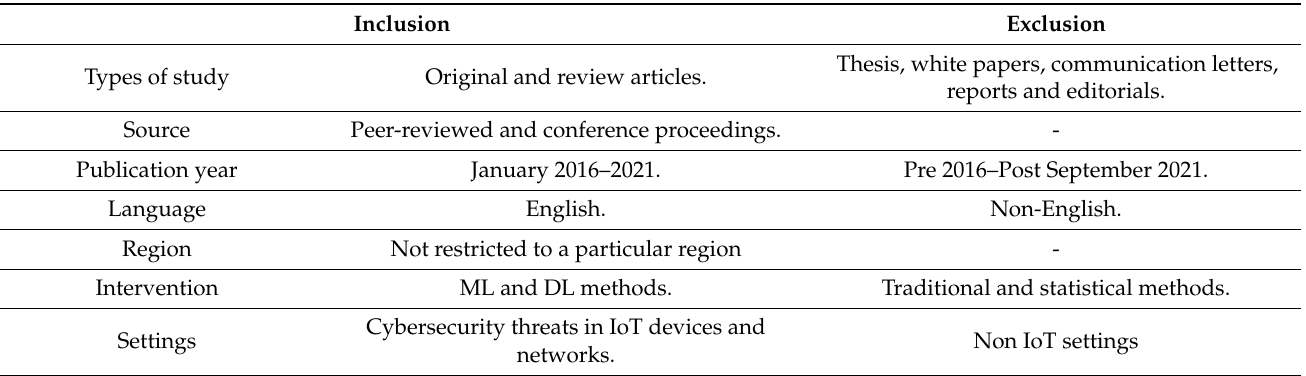
Table 3. Inclusion and exclusion